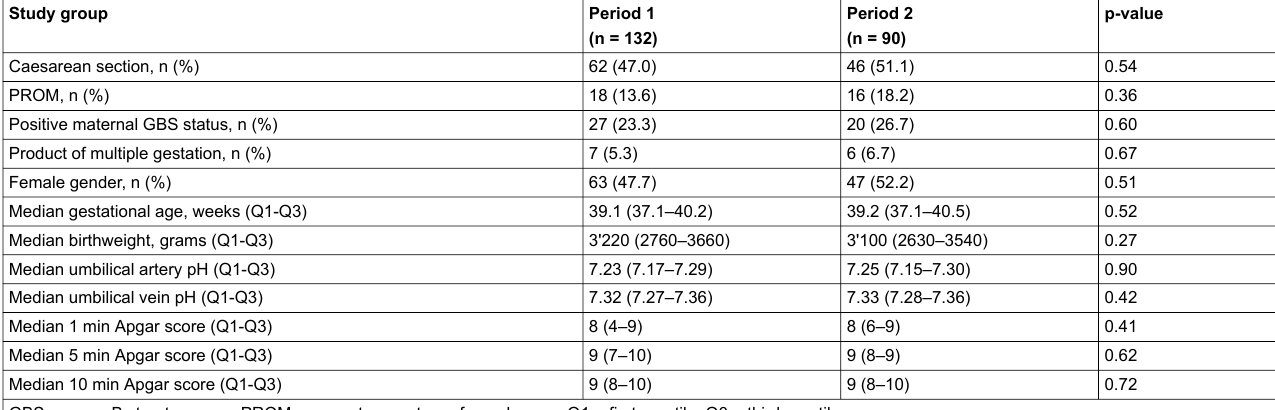
Table 1: Baseline characteristics of the newborn infants treated with antibiotics for suspected early-onset neonatal sepsis. Study